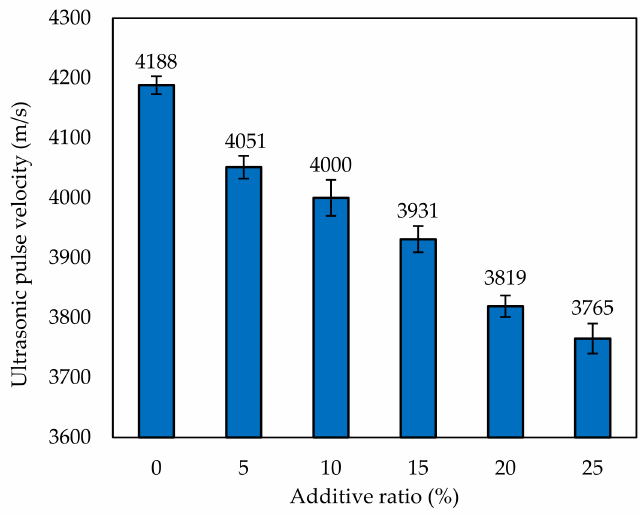
Figure 8. The ultrasonic pulse velocity test results of cementitious